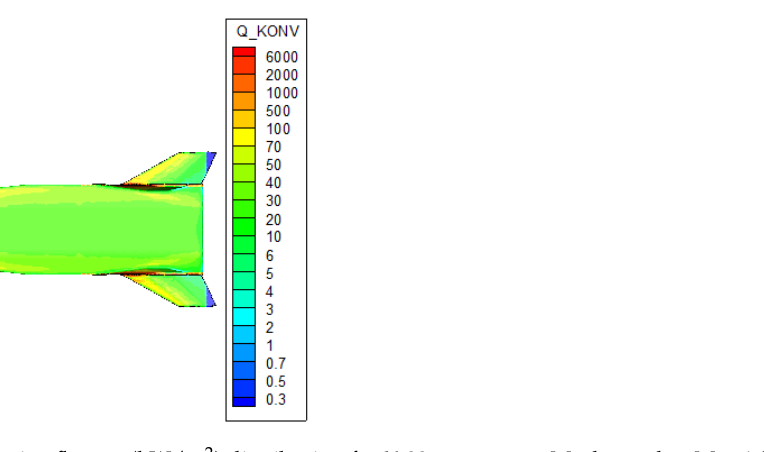
Figure 2. Distribution of convective heat flux number M = 6, height H = 25 km, attack angle = 10°.